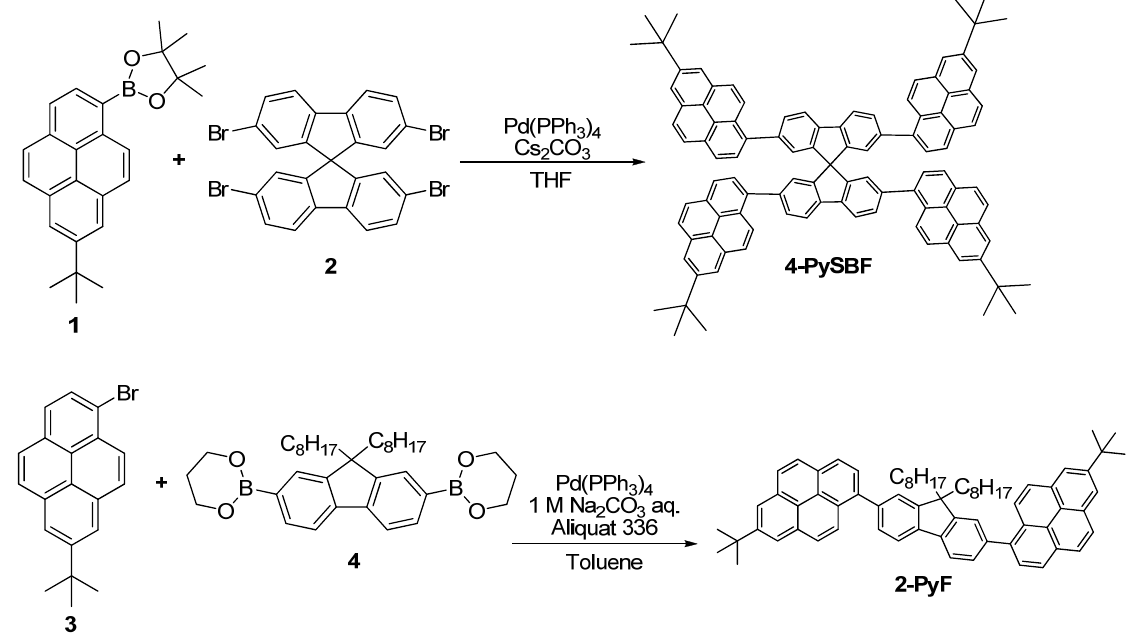
Scheme 1. Synthesis of spirobifluorene dye and model